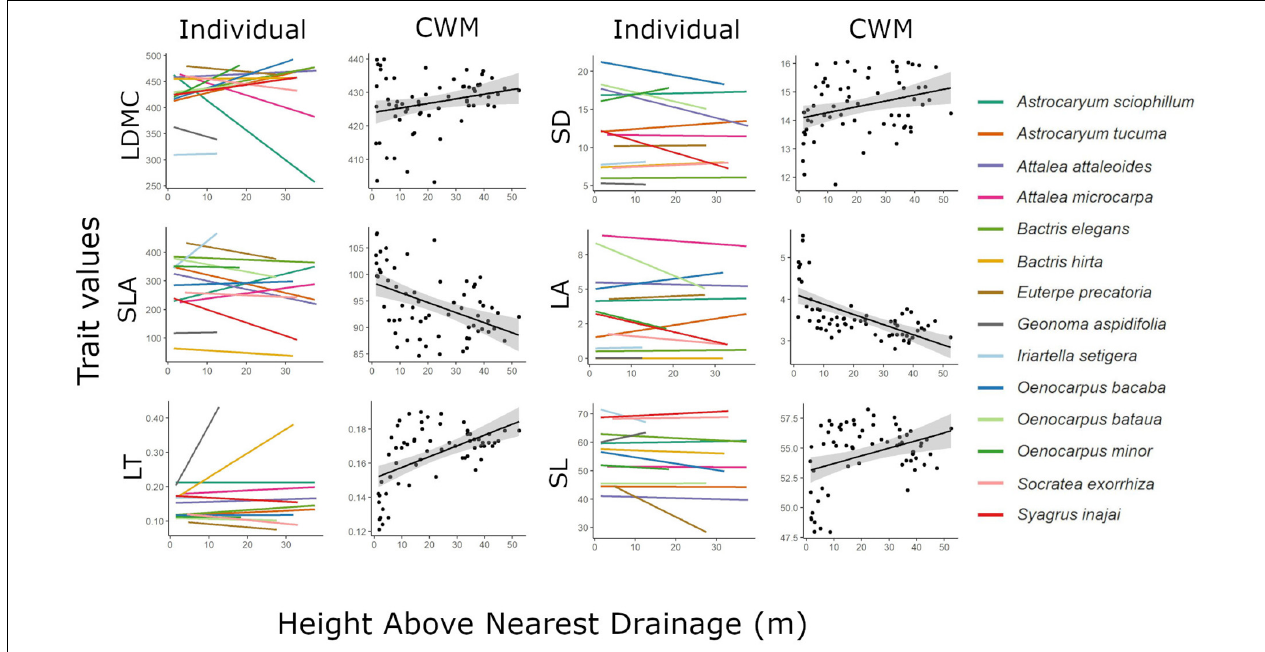
FIGURE 4 | Individual and community weighted mean (CWM) trait variation along height above nearest drainage gradient. Only relations with p -value below the threshold of 0.05 for CWM models ( Table 3 ) are shown. LDMC, leaf dry mass content; VD, venation density; LT, leaf thickness; SLA, specific leaf area; SD, stomata density; LA, leaf area; SL, stomata length.